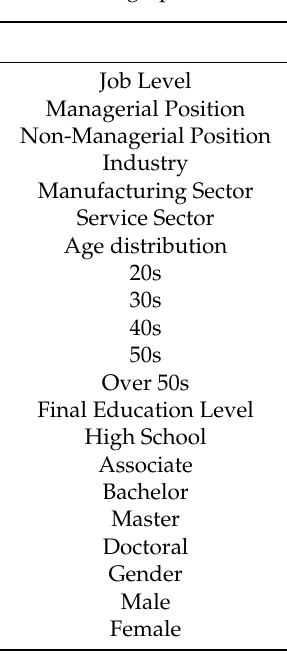
Table 4. Demographic information.